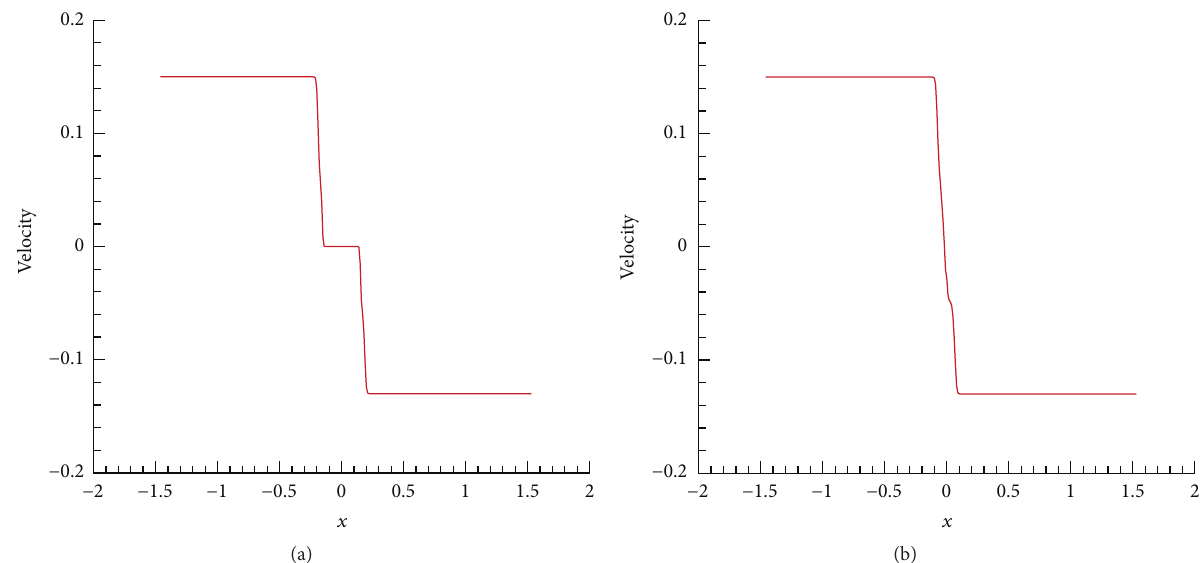
Figure 5: Numerical results of 𝑢 at 𝑡 = 1 (a) and 𝑡 = 6.5 (b) for Data 1.